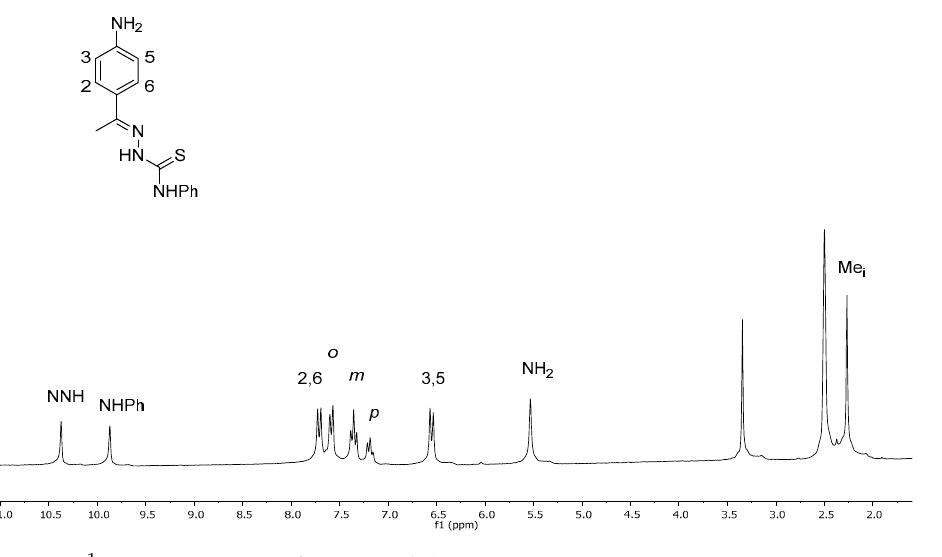
Figure 1. 1 H-NMR spectrum of compound d in DMSO. The signals for the remaining thiosemicarbazone ligands are assigned in Table 1. Table 1. Assignation of the NMR signals of compounds a – d .